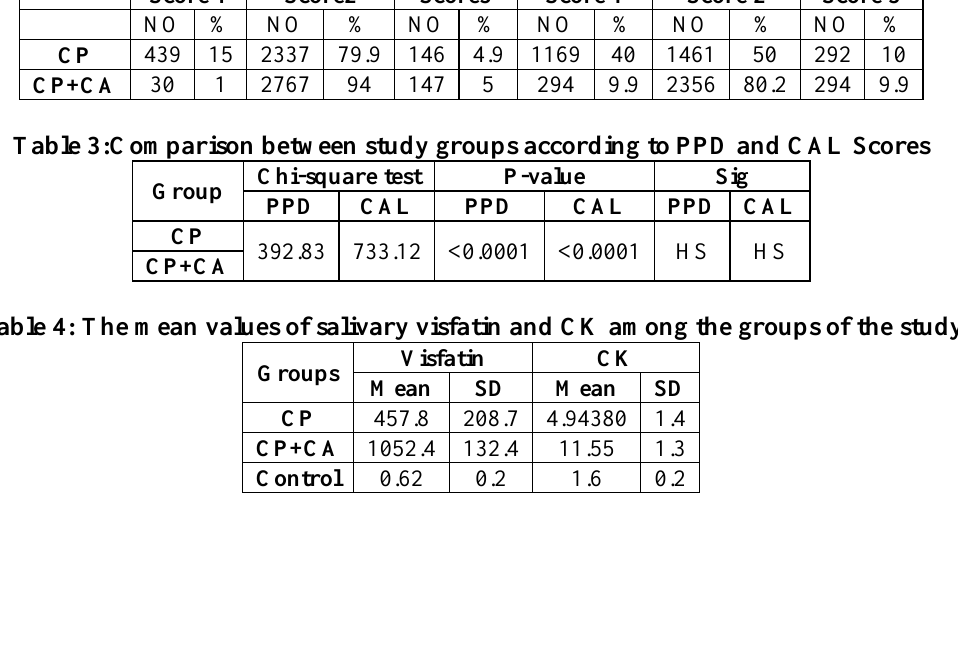
Table 2:Number and percentages of sites according to PPD and CAL for the study groups Group